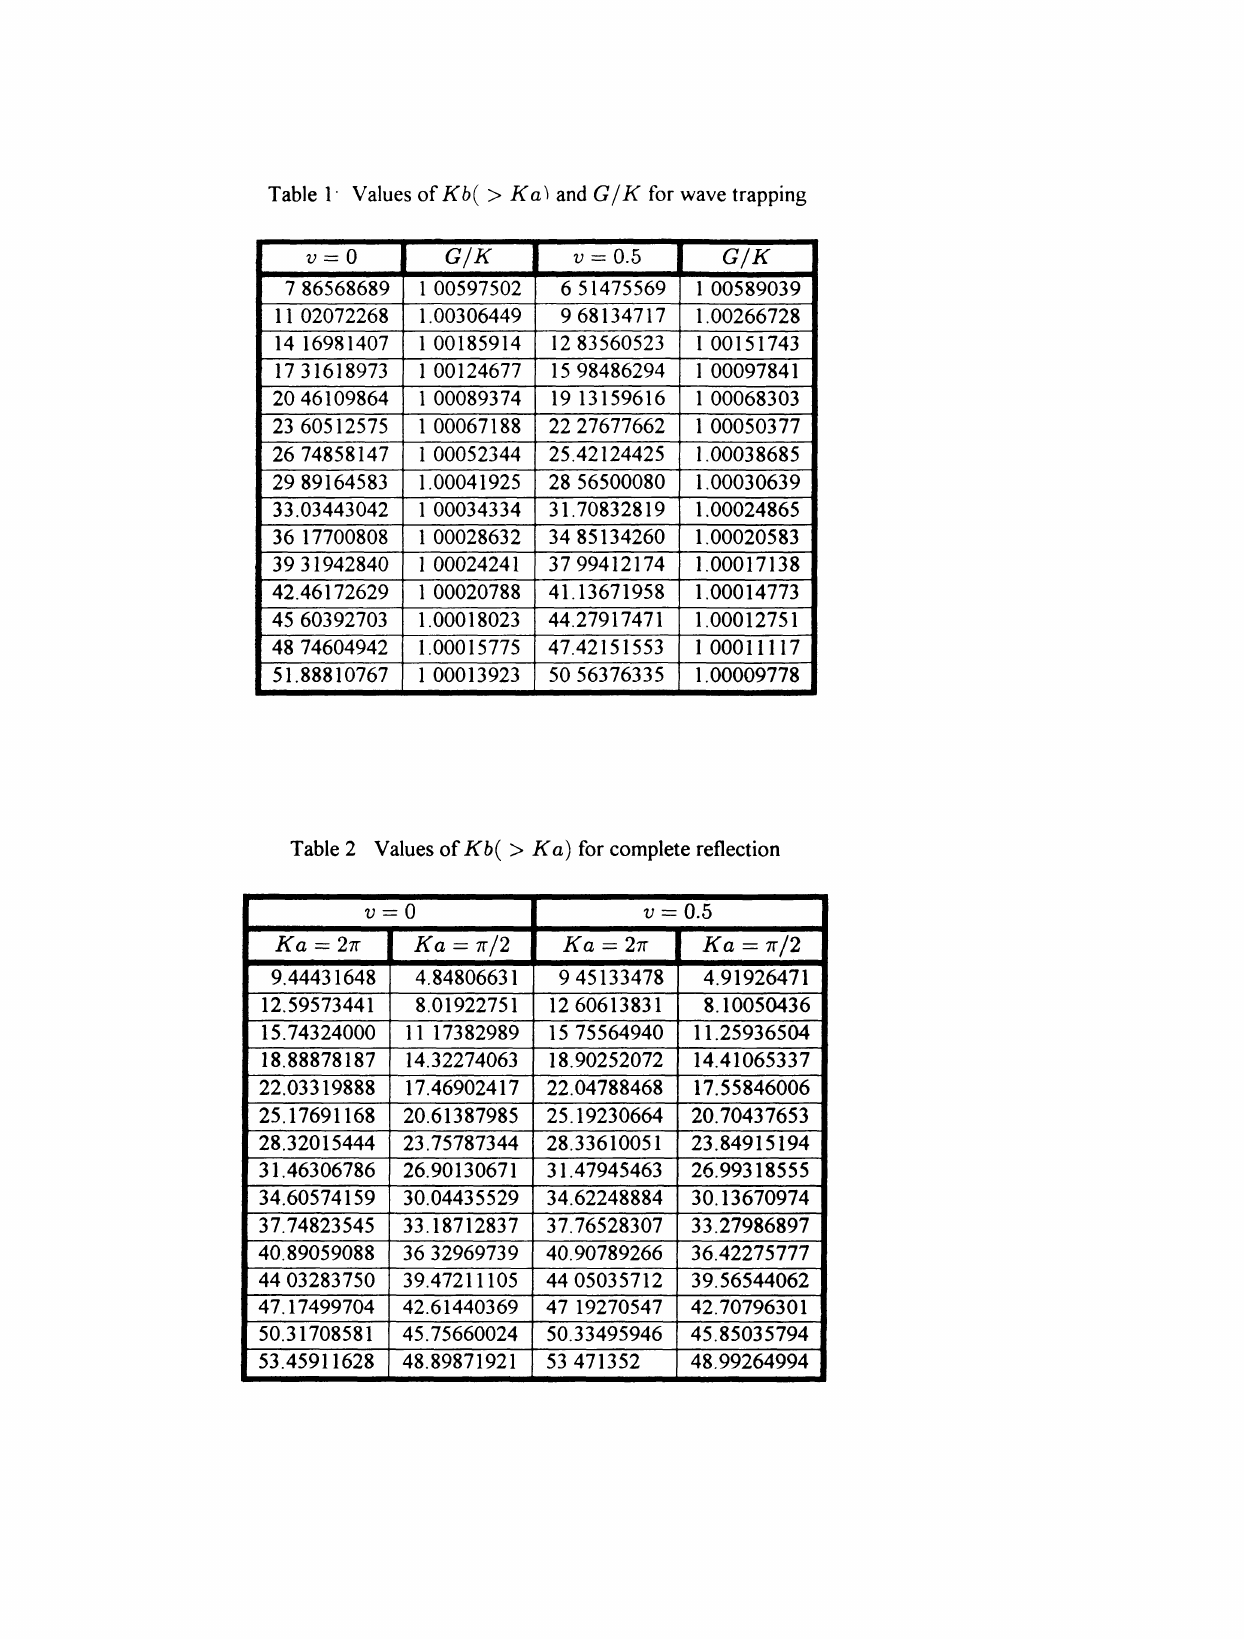
Table 1 Values of Kb( > Ka) and G/K for wave trapping